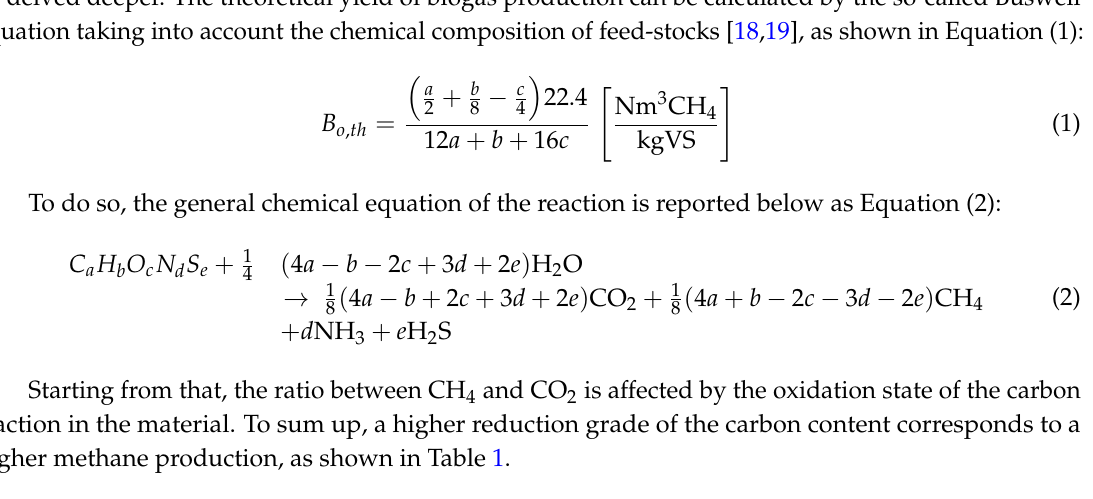
Table 1. Biogas composition calculated by the oxidation state method.